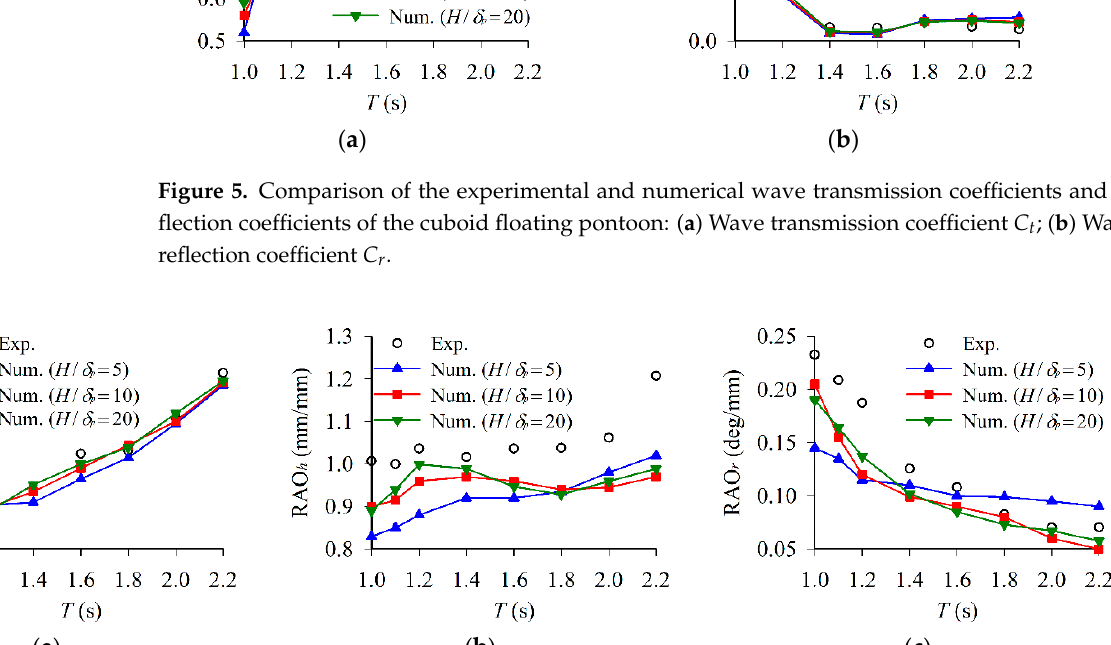
Figure 6. Comparison of the experimental and numerical response amplitude operators of the cuboid floating pontoon: